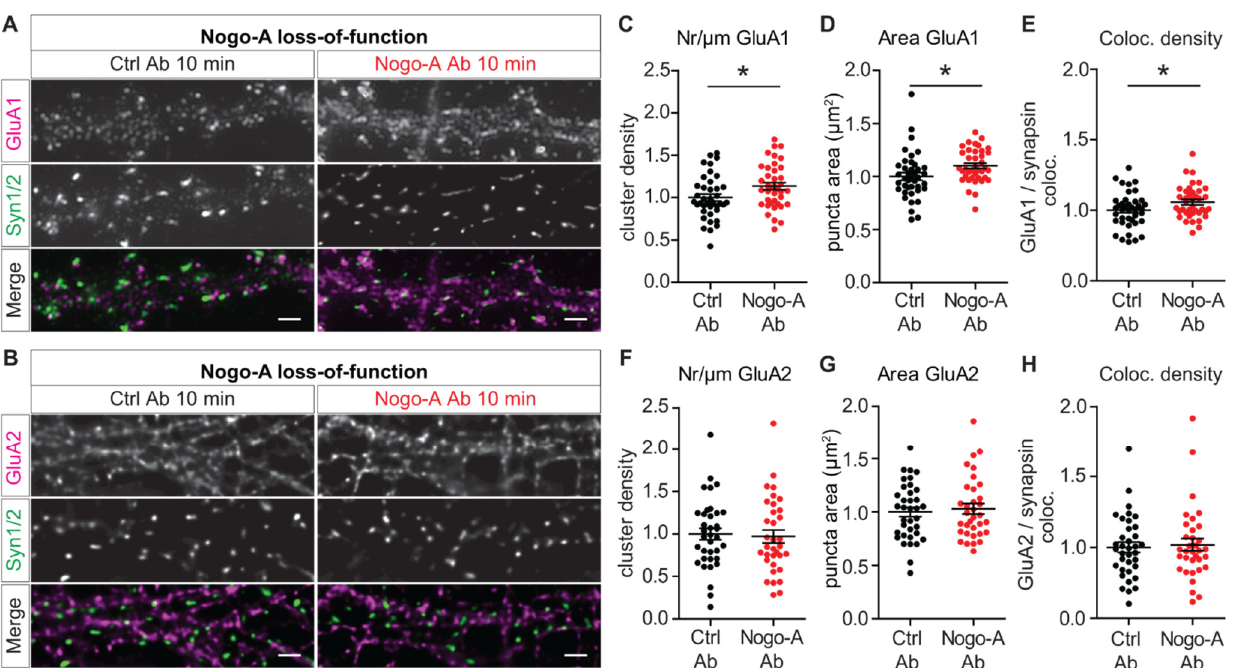
Figure 2. Nogo-A regulates the synaptic insertion of calcium permeable-AMPARs. ( A , B ) Live-cell immunolabeling of surface AMPAR subunit (magenta) GluA1 ( A ) or GluA2 ( B ) followed by immunofluorescence for presynaptic marker synapsin (Syn1/2; green) and their merged images (bottom) in primary hippocampal neurons treated for 10 min either with the control (left) or the Nogo-A function-blocking (right) antibody. For illustration, all images underwent deconvolution and were equally increased in brightness and contrast by the same absolute values for visibility. Scale bar 2 µm. ( C , D ) Normalized data for density ( C ) and fluorescence intensity ( D ) of GluA1 immuno-positive puncta in hippocampal neurons treated with either control antibody (black, n = 40) or Nogo-A function-blocking antibody (red, n = 39) for 10 min. ( E ) Normalized values for the density of GluA1 clusters colocalized with Syn 1/2 immuno-positive puncta. ( F , G ) Normalized GluA2 cluster density ( F ) and fluorescence intensity ( G ) in hippocampal neurons upon 10 min application with control antibody (black, n = 36) or Nogo-A function-blocking antibody (red, n = 35). ( H ) Normalized density of GluA2 immuno-positive puncta colocalized with Syn 1/2. Data are presented as mean ± SEM. * p < 0.05.